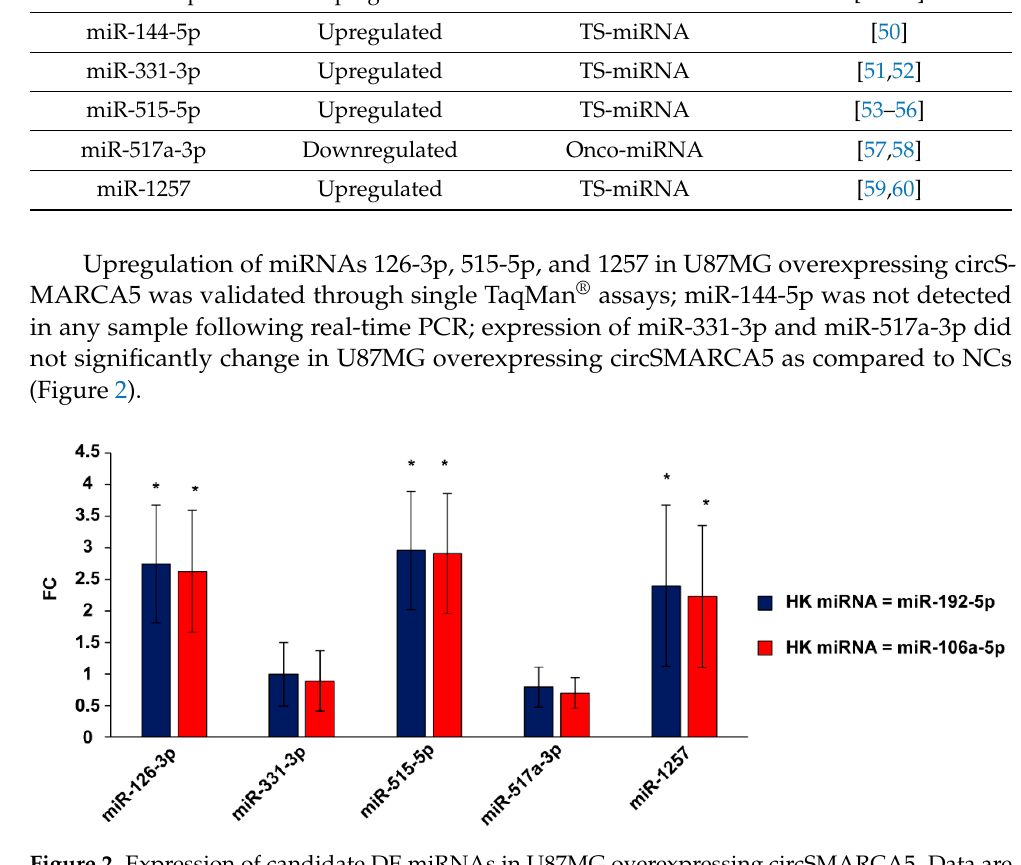
Table 1. Upregulated TS miRNAs and downregulated onco-miRNAs chosen as candidate DE miR- NAs to be further analysed through single TaqMan ® assays.